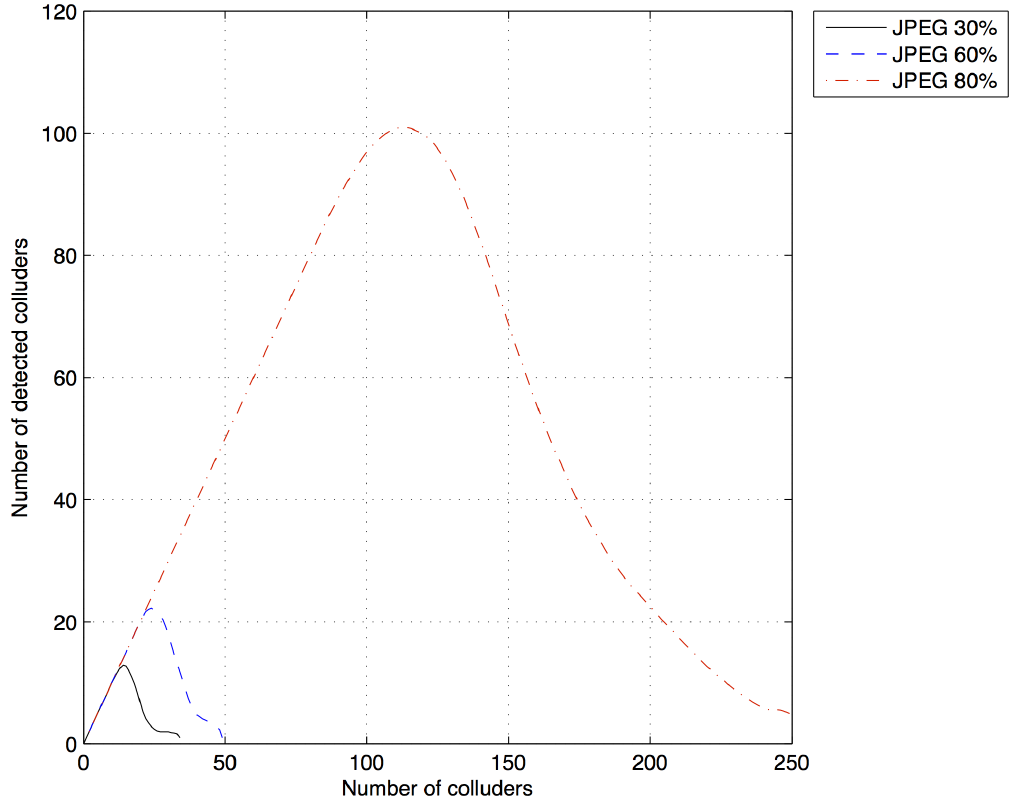
Figure 9. Number of detected colluders after a collusion attack with lossy digital documents for fingerprints generated with B